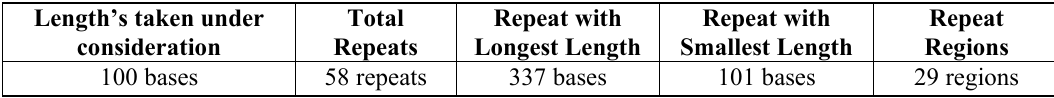
Table 3. S. cerevisiae (Brewer's Yeast) First Chromosome’s Repeats Having 100% Similarity Length’s taken